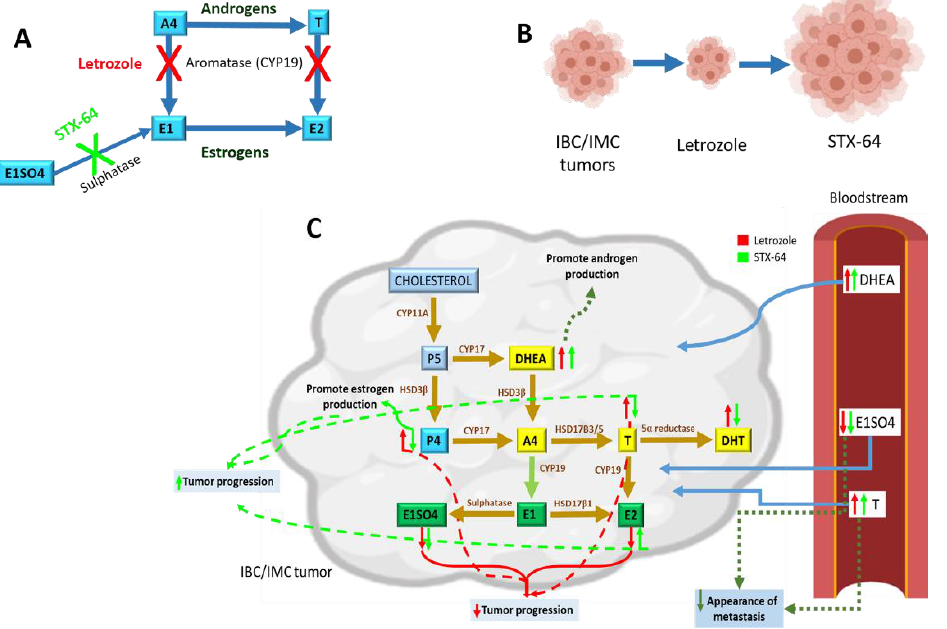
Figure 6. Scheme of the effect of estrogen blockade on steroid hormone synthesis. ( A ) Routes of estrogen synthesis from androgens highlighting the effect of letrozole as an aromatase inhibitor, and STX-64 as an estrone sulfatase inhibitor. ( B ) Represents the control tumors of the IPC-366 and SUM149 xenografts, and the effect of letrozole on them, which decreases tumor progression, and of STX-64, which increases tumor progression. ( C ) Effect of letrozole and STX-64 treatments on the steroidogenic pathways in tumors and serum from IPC-366 and SUM49 xenografts. Briefly, an intratumoral increase in DHEA levels has been shown to promote androgen synthesis, while a decrease in P4 promotes estrogen synthesis. High levels of intratumoral estrogens are related to an increase in tumor progression. Additionally, high levels of circulating testosterone in addition to low levels of E1SO4 are related to a low appearance of metastasis.